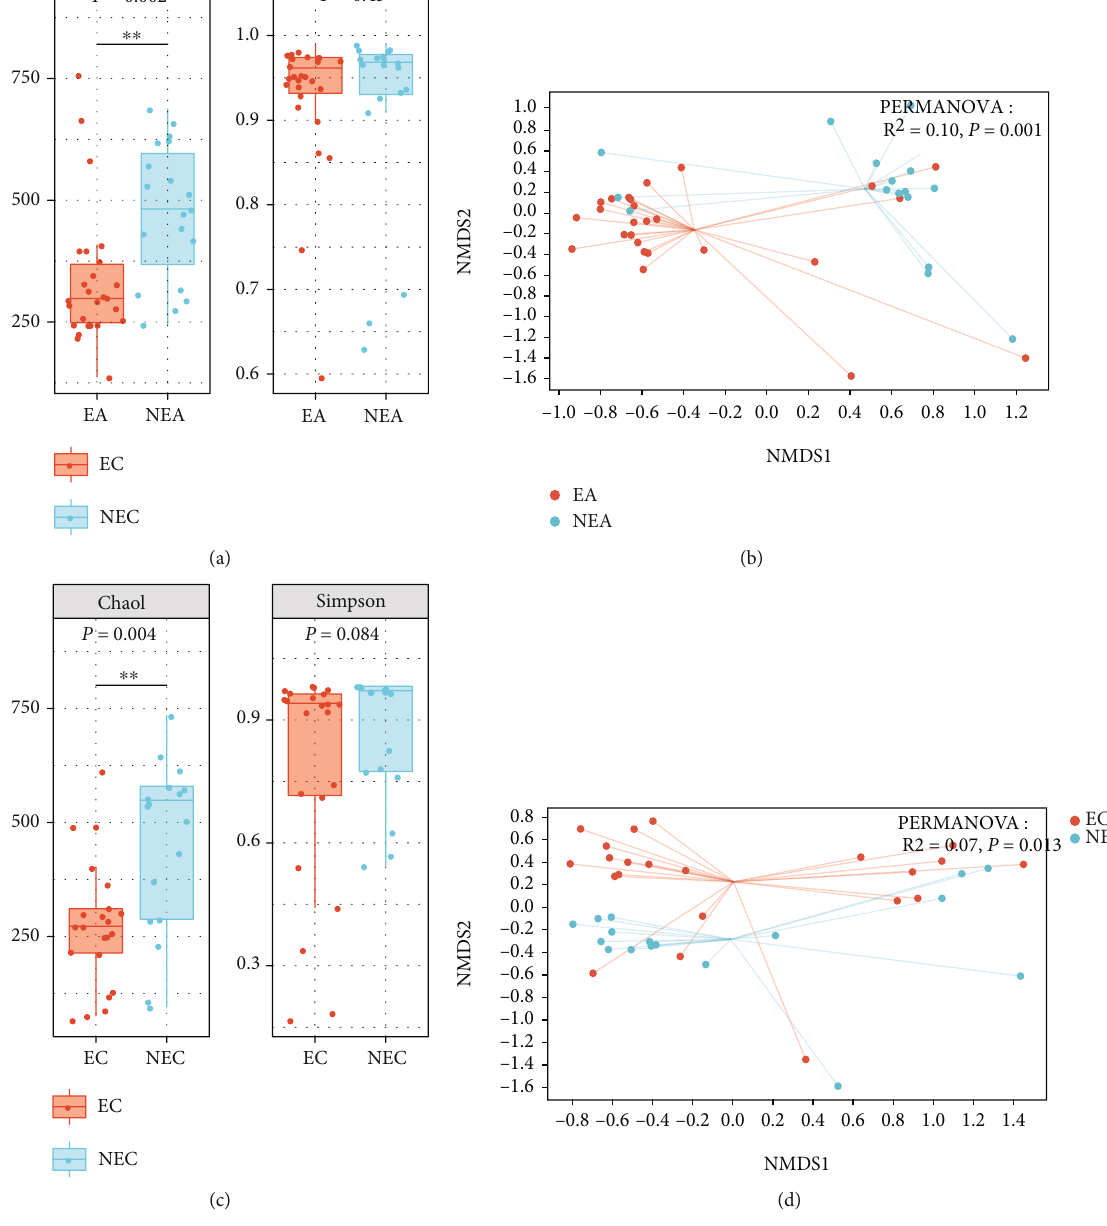
Figure 4: Alpha diversity and beta diversity of bacterial microbiota. Each dot represented a sample. Box plots of the Chao1 index and Simpson index, to compare alpha diversity (a) between EA and NEA and (c) between EC and NEC. The y -axis represented the value of the corresponding Chao1 or Simpson index. The statistical analysis was performed using Wilcoxon rank-sum test and Dunn ’ post hoc test. NMDS analysis based on the Bray-Curtis distance to compare beta diversity (b) between EA and NEA and (d) between EC and NEC. PERMANOVA was employed to reveal beta diversity